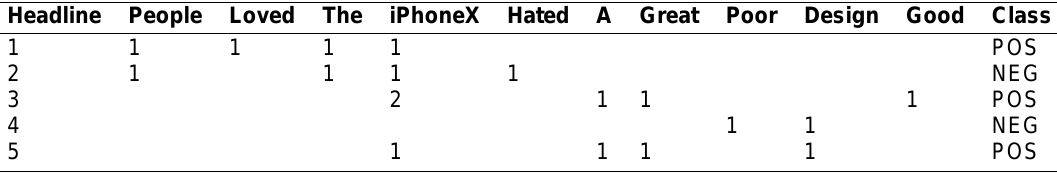
Table 2. Feature Matrix